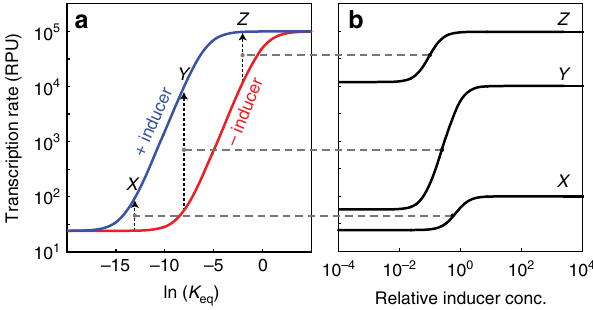
Fig. 1 Ligand-inducible promoters have different dynamic ranges. a Theoretically predicted transcription rate of a ligand-inducible promoter as a function of the relative equilibrium constant of σ -factor binding to the − 10 and − 35 sites, ln( K eq ) = − ( Δ G − 10 + Δ G − 35 ) (see